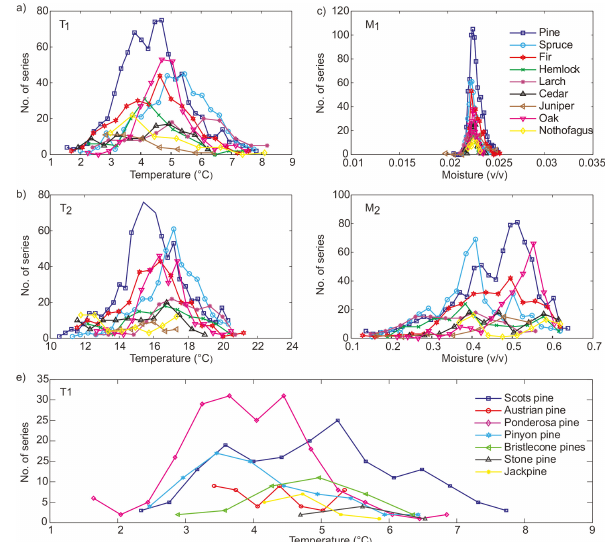
Fig. 3. Histogram of the Bayesian estimated VSL growth response parameters: (a) T 1 , lowest threshold temperature; (b) T 2 , lower bound for optimal temperature; (c) M 1 , lowest threshold for mois- ture; (d) M 2 , lower bound for optimal moisture parameters cal- culated during 1911–1970 for different tree genera: pine (pinus; n = 821), spruce (picea; n = 407), fir (abies; n = 286), hemlock (tsuga; n = 124), larch (larix; n = 126), cedar (cedrus; n = 107), juniper (juniperus; n = 40), oak (quercus; n = 253), and south- ern beech (nothofagus; n = 62). Histogram of T 1 threshold tem- perature for different pine species (e) : Scots pine ( Pinus sylvat- ica ; n = 172), Austrian pine ( Pinus negra ; n = 45), ponderosa pine ( Pinus ponderosa ; n = 181), pinyon pine ( Pinus edulis ; n = 73), bristlecone pine ( Pinus aristata , Pinus longaeva , and Pinus bal- fouriana ; n = 34), stone pine ( Pinus pinea ; n = 7), and jack pine ( Pinus banksiana ; n = 15). Numbers in brackets give the series con- tributing in each group of tree genera. The number of bins for each parameter is determined through the square root of its